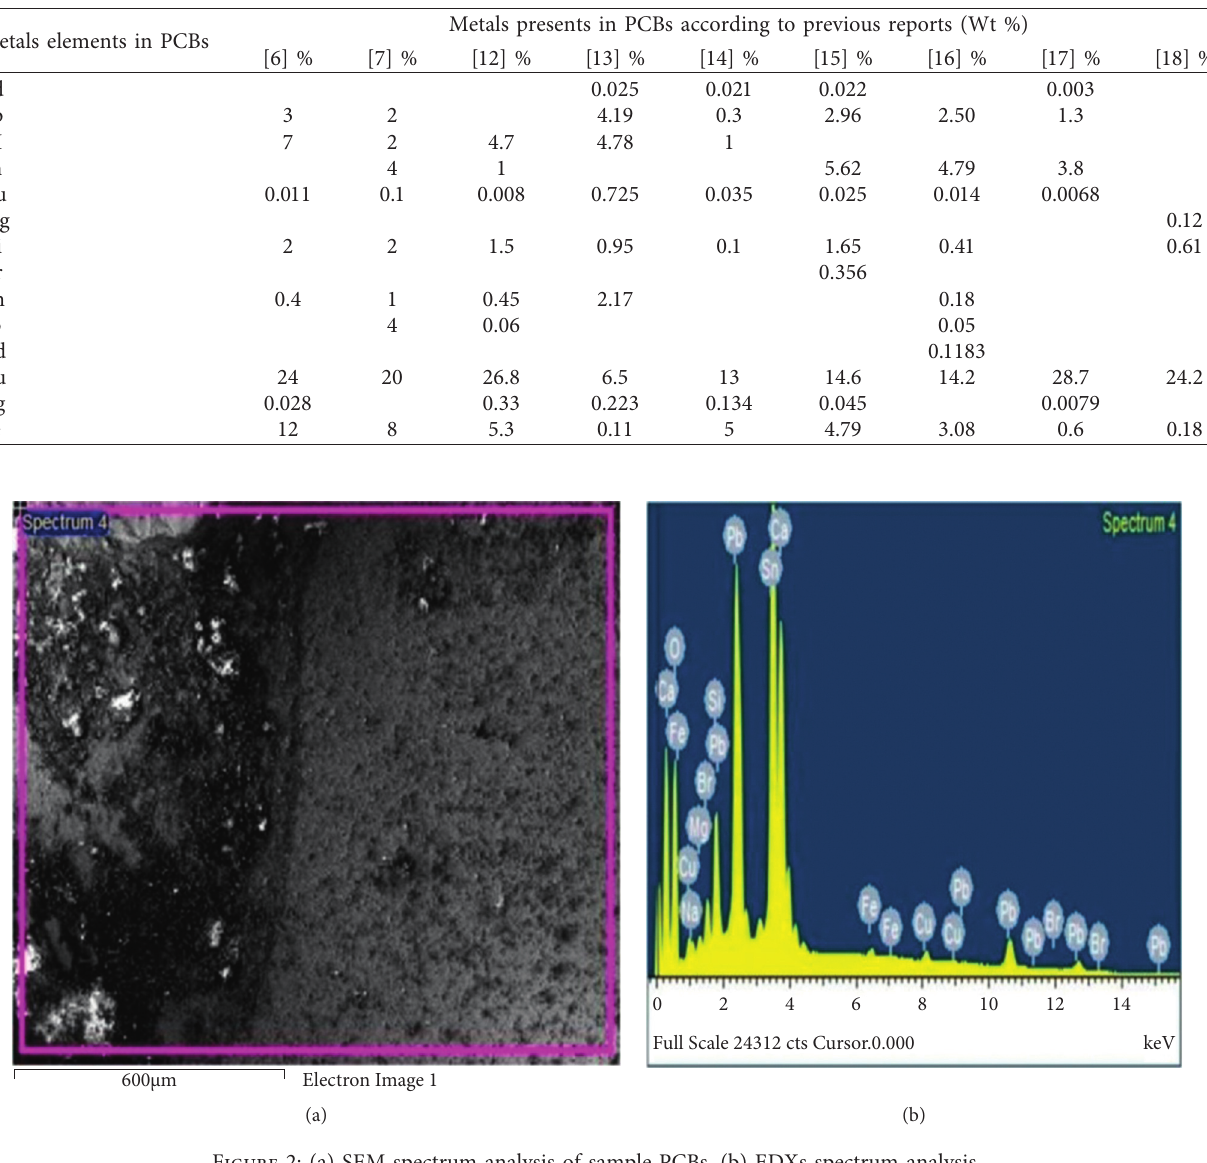
Figure 2: (a) SEM spectrum analysis of sample PCBs, (b) EDXs spectrum